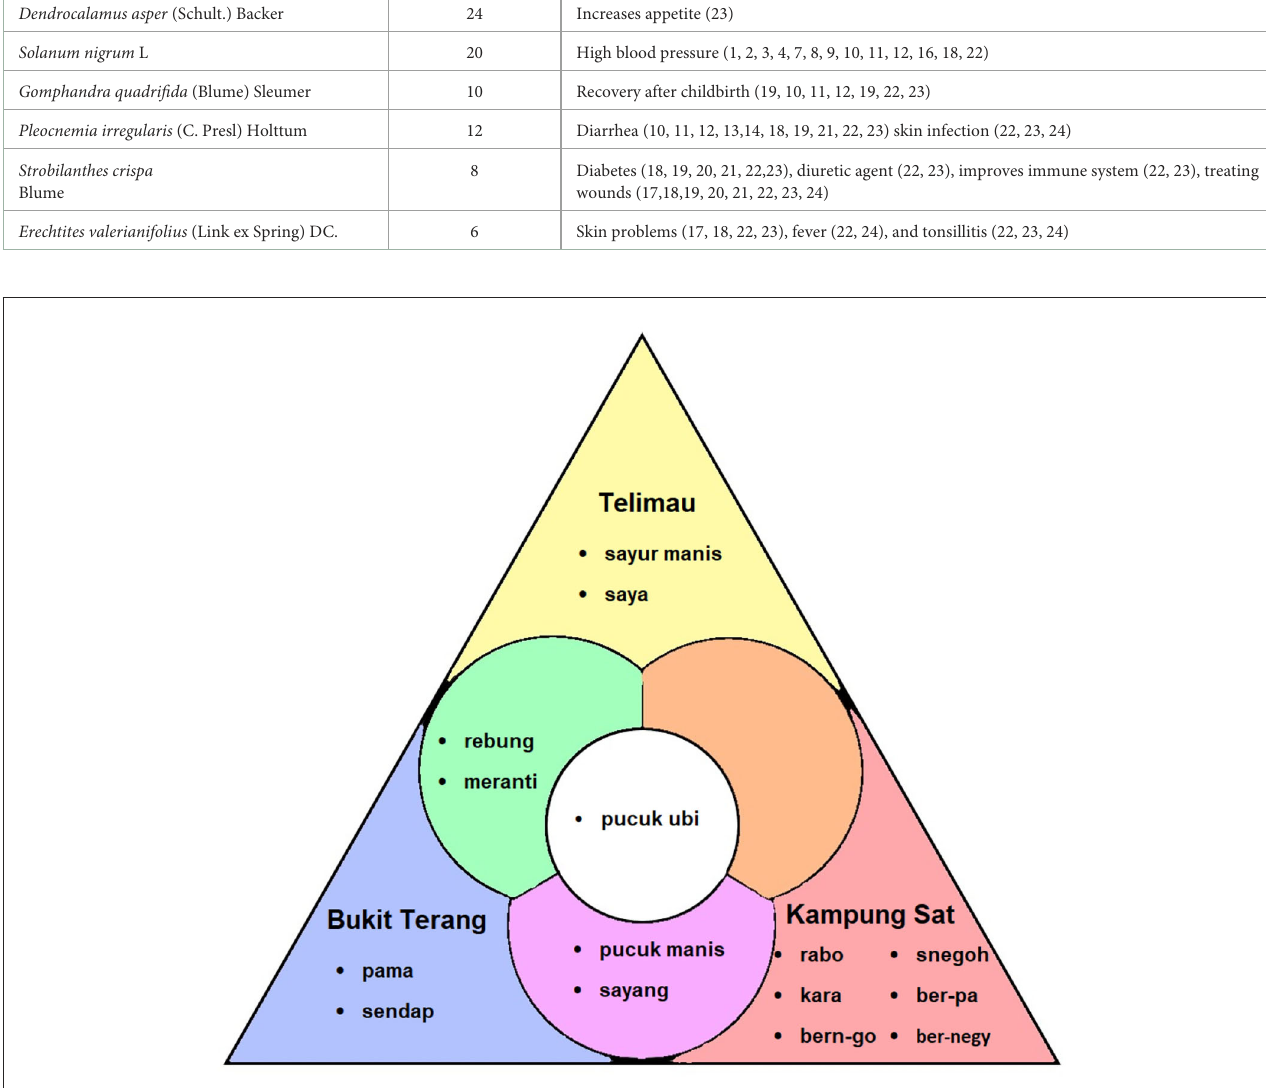
FIGURE3 Common usage of name between